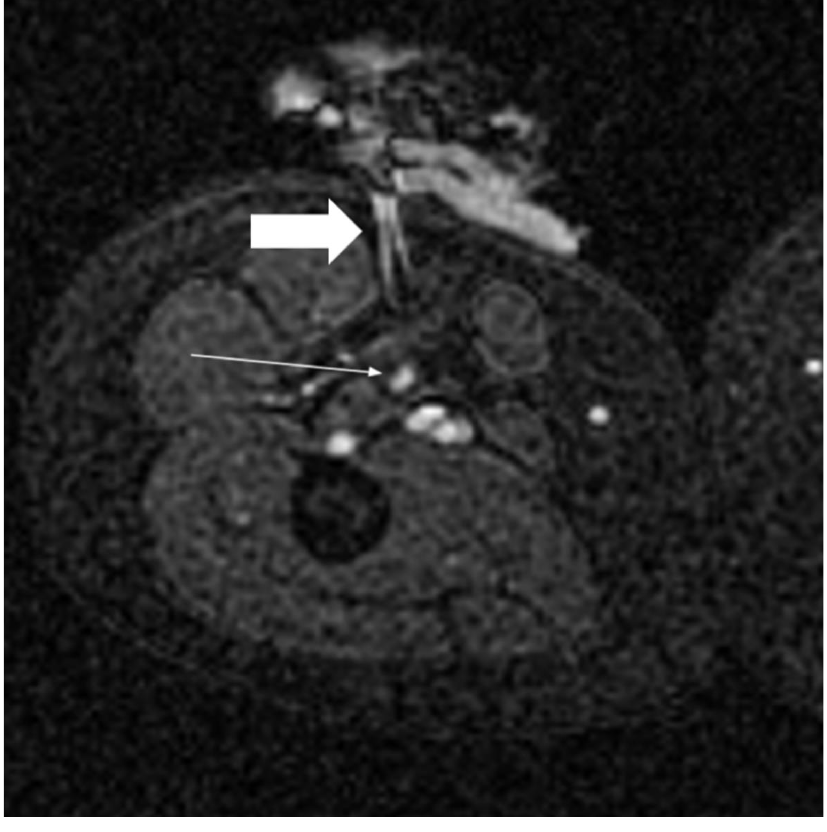
Figure 9. Image from a MR-guided cryoablation of a small relapse of soft-tissue tumor (thin white arrow); the MR-compatible needle for cryoablation (thick white arrow) with MR artifact.